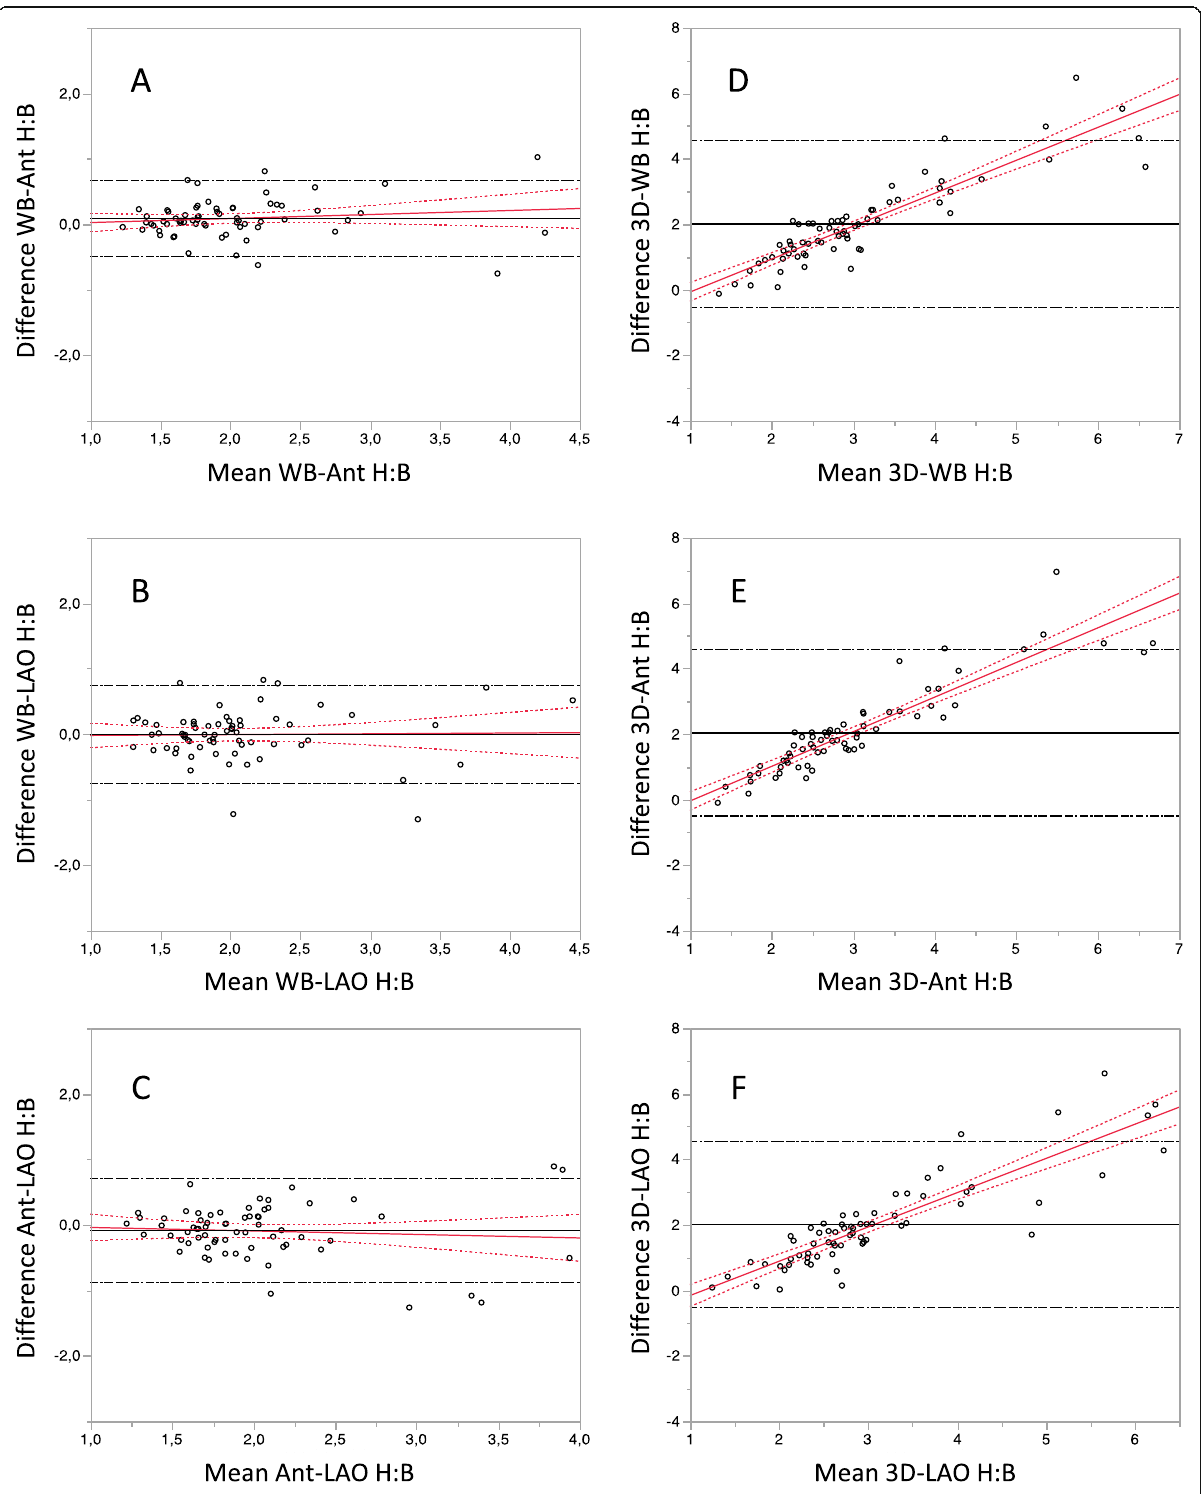
Fig. 1 Bland-Altman analysis showing (1) a high agreement between all planar methods for the measurement of the heart-to-background (H:B) uptake ratio ( a - c ) and (2) an underestimation of the high H:B uptake ratio using planar methods as shown by the increased difference between 3D-H:B and planar H:B ratios for high H:B ratio values ( d – f ). WB, whole-body H:B; Ant, anterior planogram H:B; LAO, left anterior oblique planogram